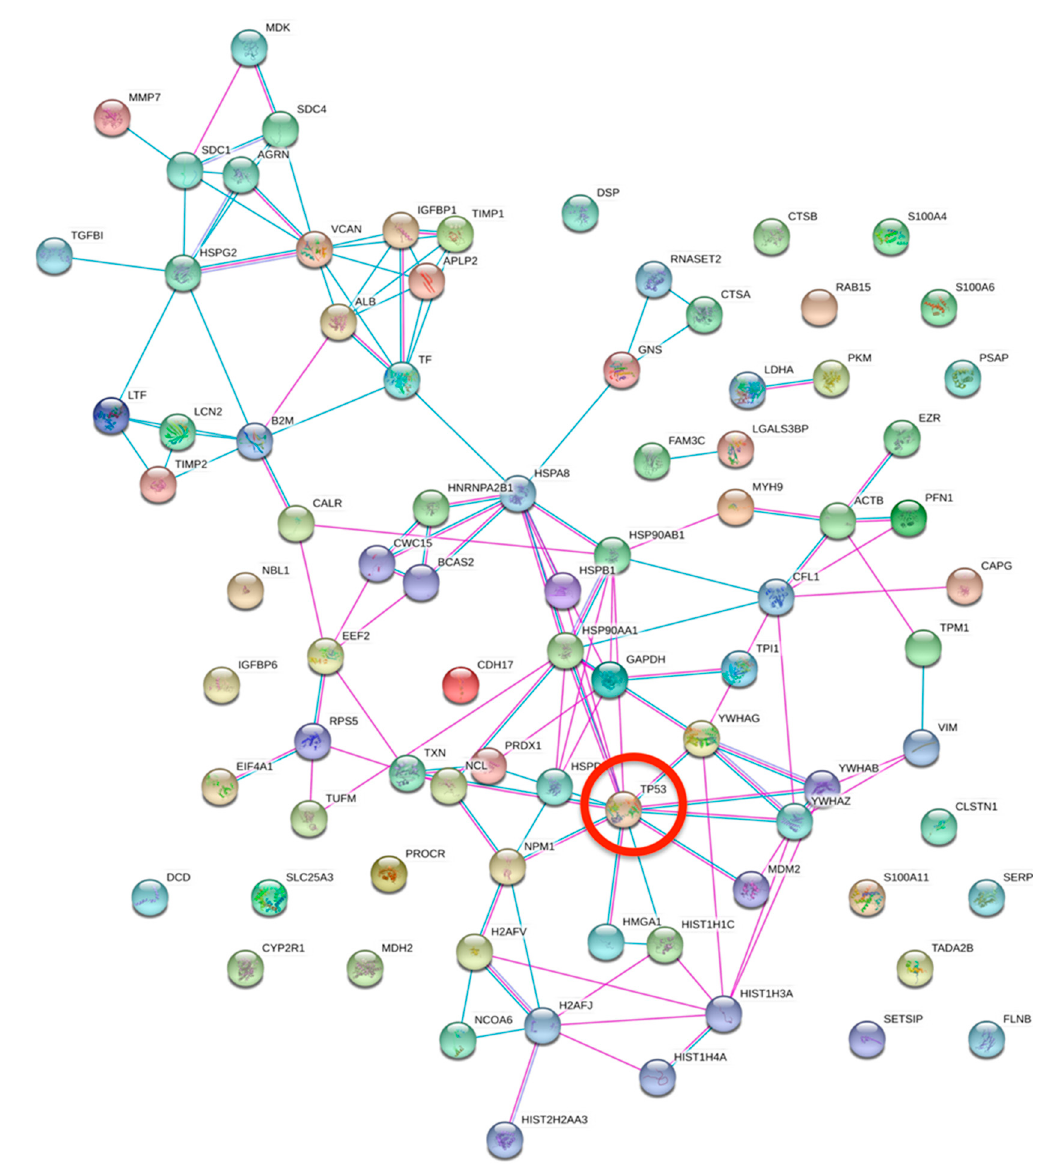
Figure 6. STRING analysis. Protein-protein interactions among modulated proteins secreted by both R273H and R175H transfected cells. TP53 was manually added to identify potentially related connections. Among the modulated proteins, 11 proteins are clustered in a tight interaction network centered on p53.